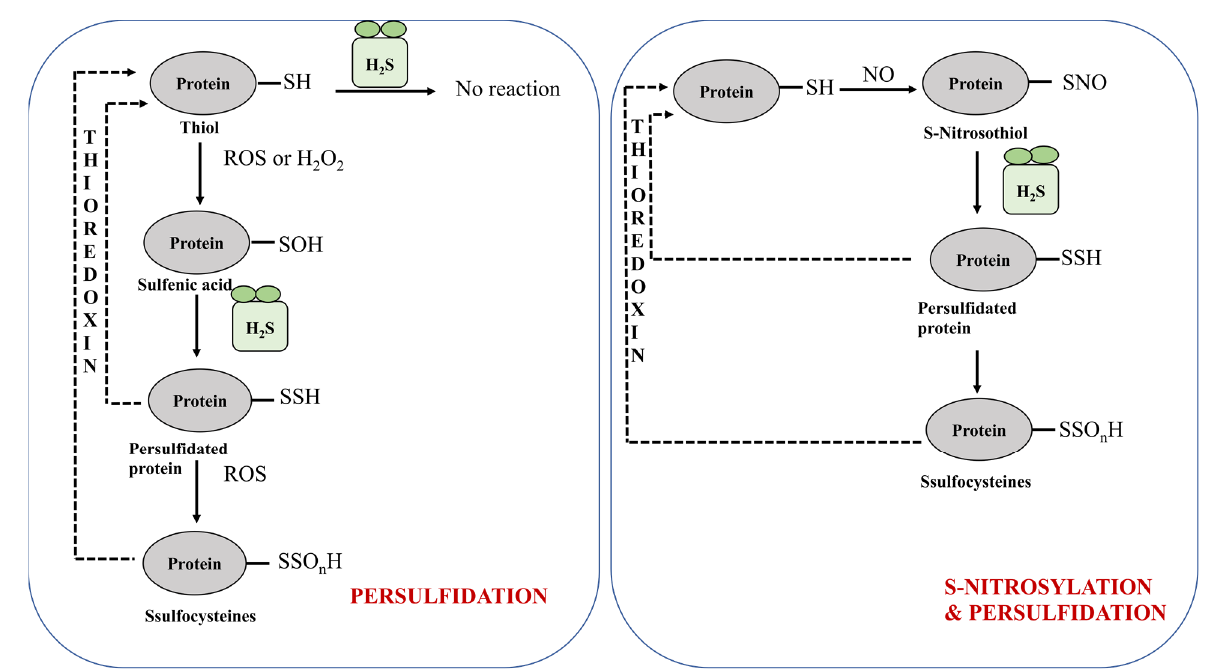
Figure 5. A brief model explaining persulfidation and S-nitrosylation in plants. The thiol group of protein undergo oxidation in presence of ROS and form sulfenic acid, which then undergo persulfidation in the presence of hydrogen sulfide to form persulfidated protein. If the persulfidated protein is exposed to ROS, S-sulfocysteines are formed. Both S-sulfocysteines and persulfidated proteins can revert back to thiol form by thioredoxin. In S-nitrosylation, nitric oxide (NO) combines with thiol group of protein to form S-nitrosothiol, which can further react with hydrogen sulfide to form persulfidated protein, which can then revert back to thiol form in presence of thioredoxin.